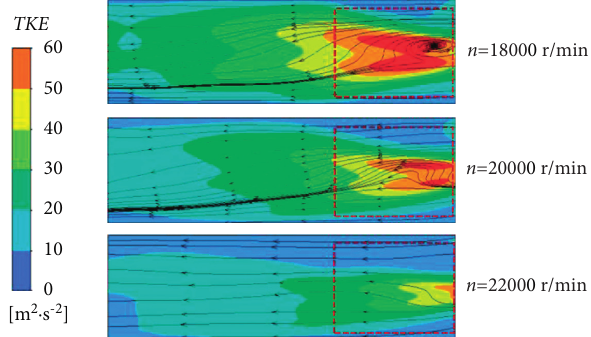
Figure 16: Distribution of streamline and TKE of the draft